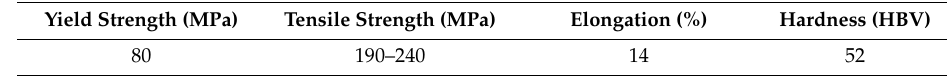
Table 2. Mechanical properties of the